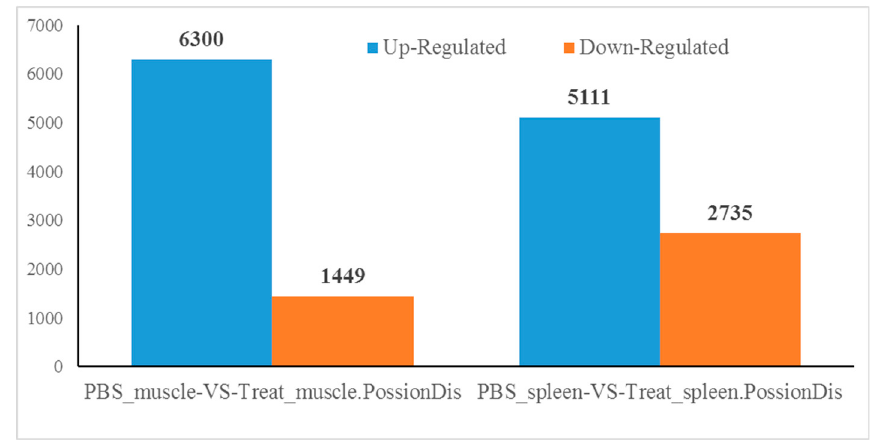
(from the ‘cellular component’ category); and binding, catalytic activity and molecular transducer activity (from the ‘molecular function’ category). activity (from the ‘molecular function’ category).